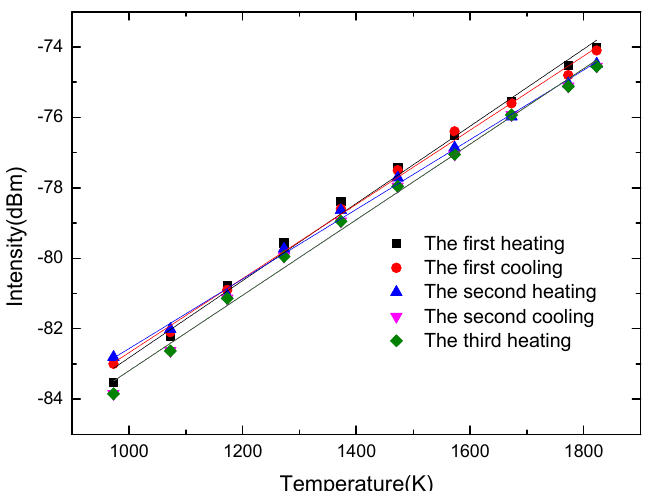
Figure 4. The temperature response curves of the optical fiber infrared radiation sensor in the three heating processes.